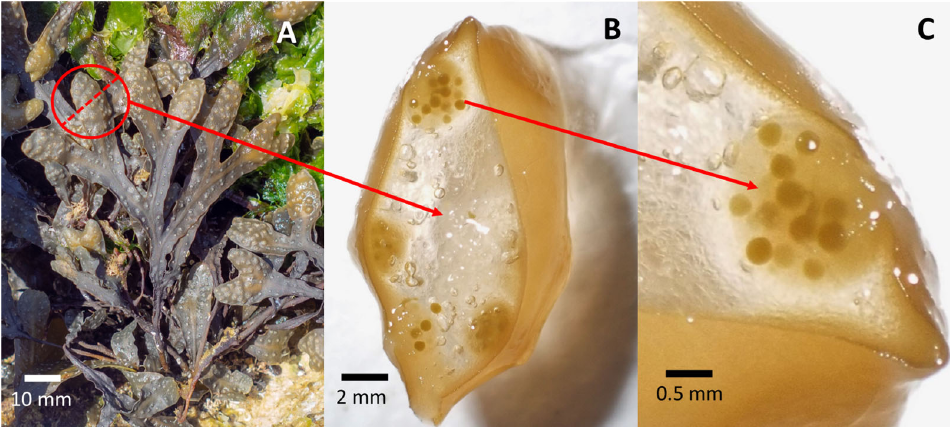
Figure 7. Fucus virsoides thallus with receptacle marked with a red circle ( A ), transverse section of a receptacle showing conceptacles ( B ), magnification showing conceptacle with mature gametangia ( C ).